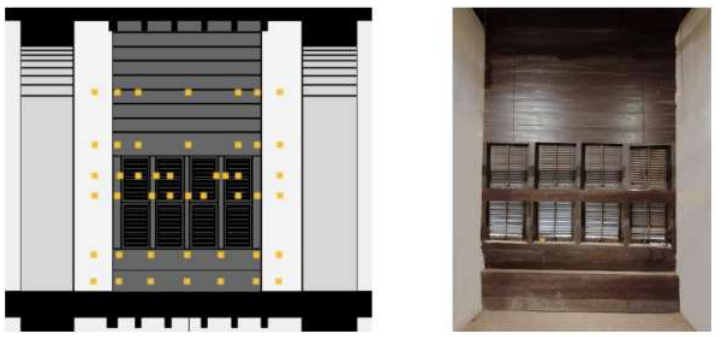
Figure 13. The mashrabiya and grids in Room 1.